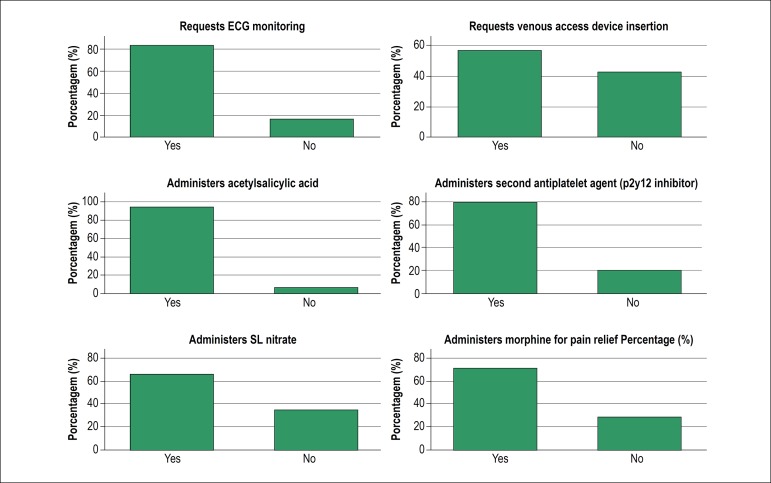
Bars graphic showing the performance of the recently graduated physicians in each of the six items of the cheklist related directly to the treatment during practical assessment in the simulated station of STEMI medical care.